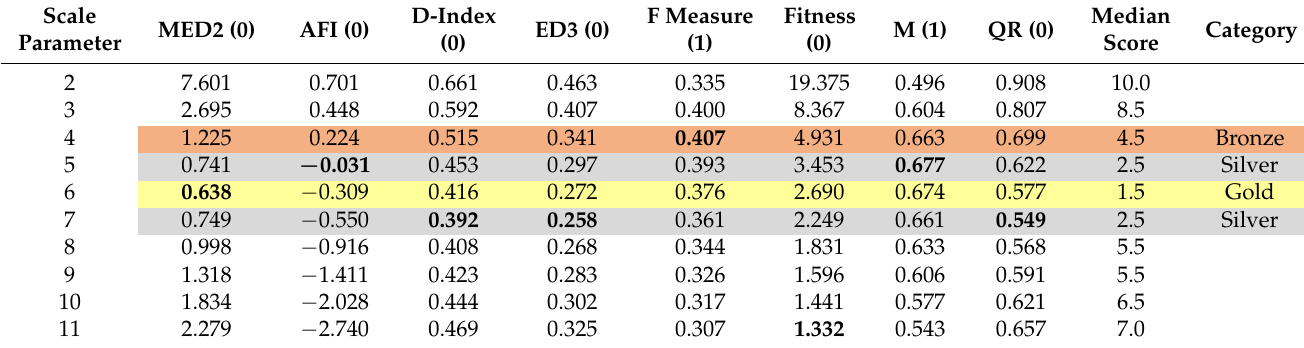
Table 3. Computed segmentation accuracy metrics and median values of visual rankings for the S2 Percent image taken at the Almer í a study site on 25 December 2020. Optimal values for each metric are indicated within parenthesis, whereas optimal values among the ten segmentations for each metric are shown in bold. The best three categories for the median scores are